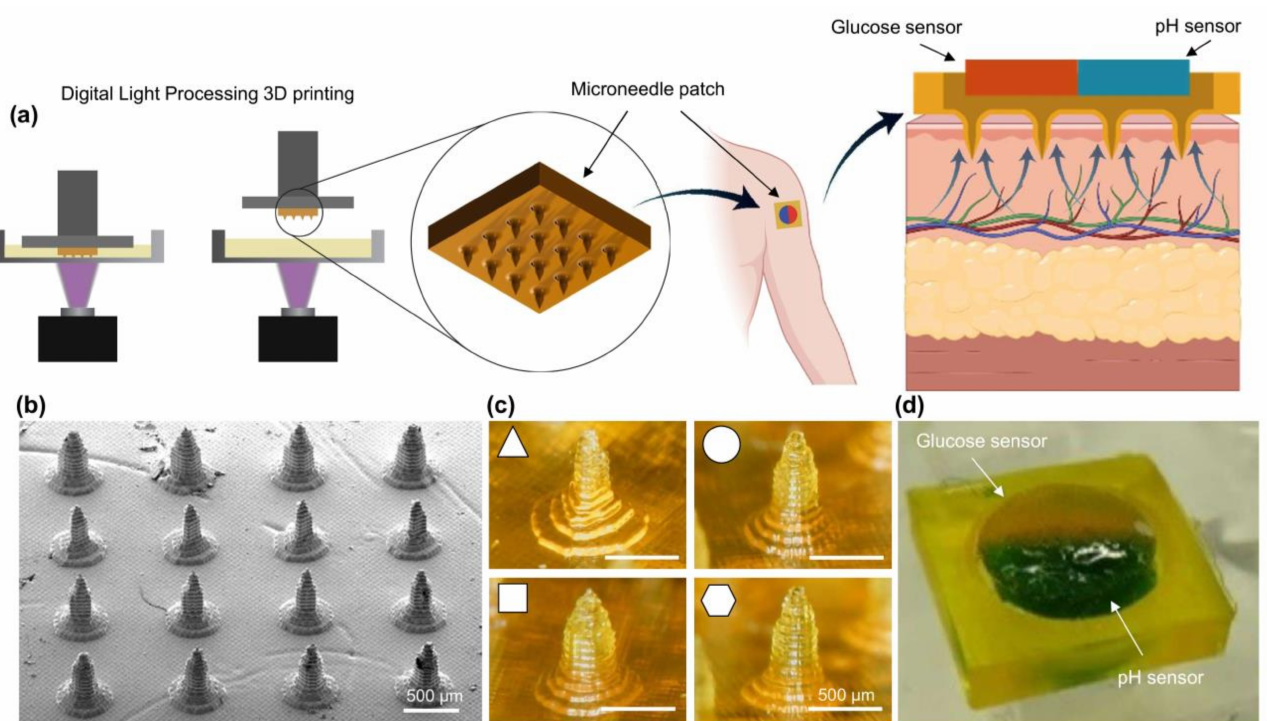
Figure 1. Schematic illustration of the application process of ( a ) Hydrogel-based microneedle patch; ( b ) Scanning electron microscopy (SEM) image of MNA; ( c ) Printed microneedles with different cross-sections; ( d ) Microneedle